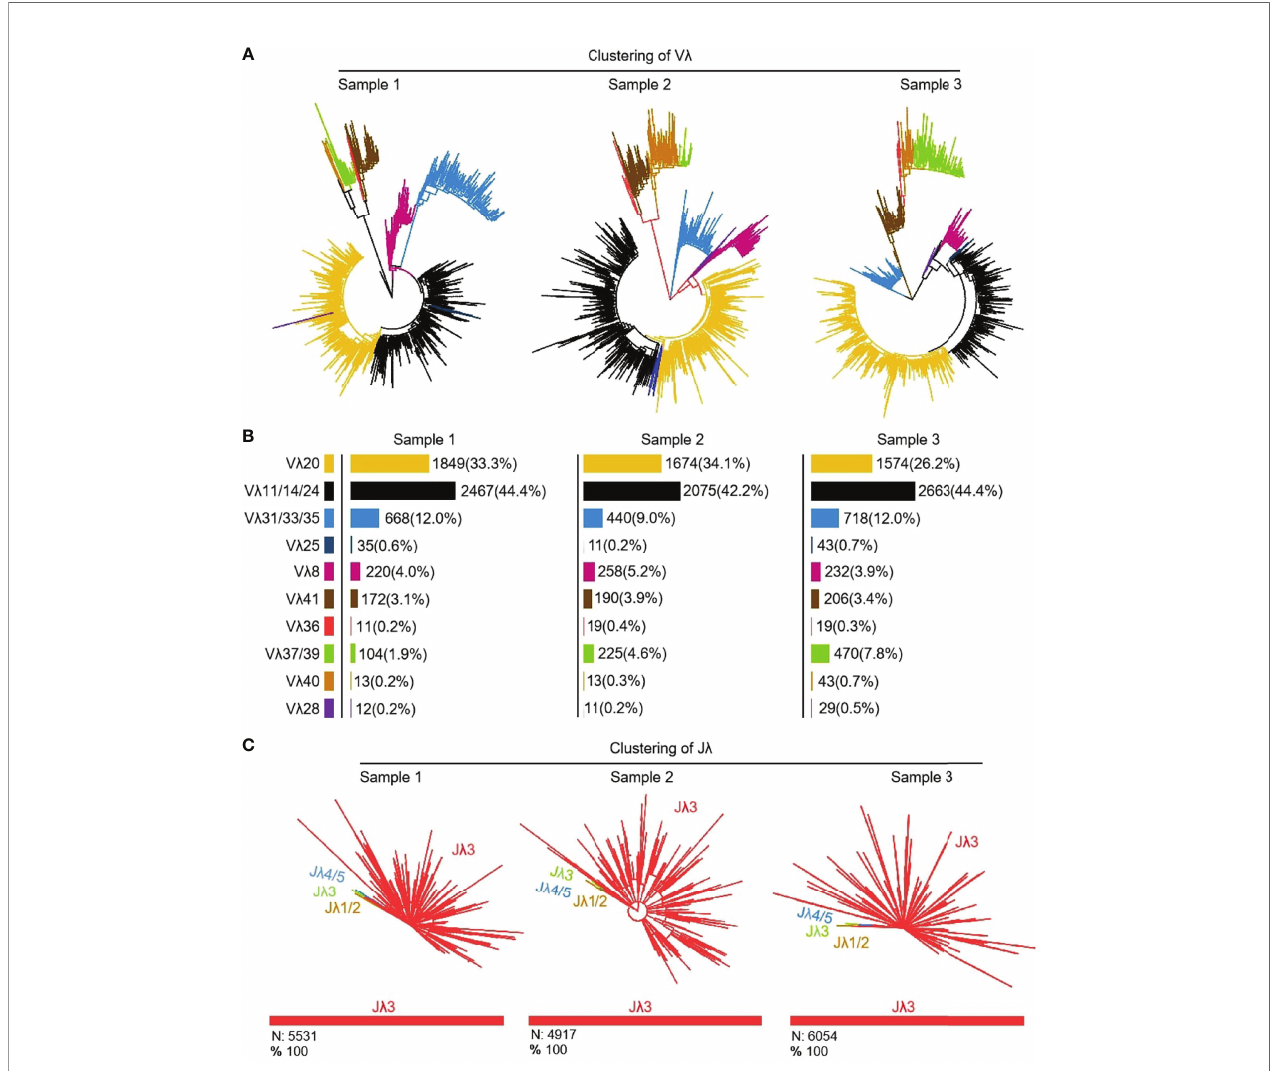
FIGURE 11 | The V l and J l genes usage in yak IgL ( l ). (A, B) Expression of the yak V l ; (C) Expression of the yak J l